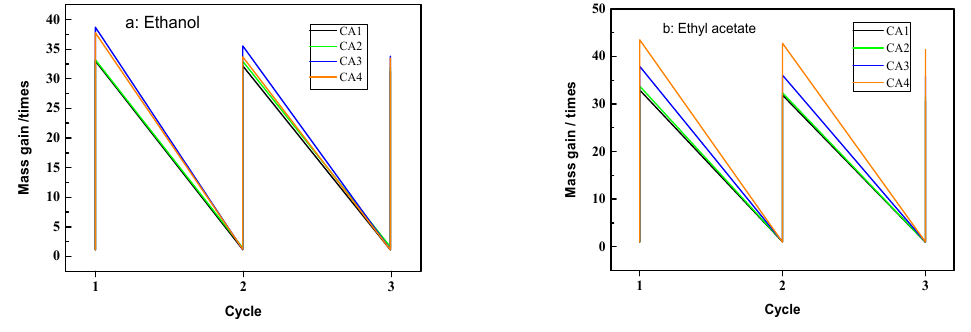
Figure 7. Recyclability of carbon aerogels for adsorption of ethanol ( a ) and ethyl acetate ( b ) with a distillation method.